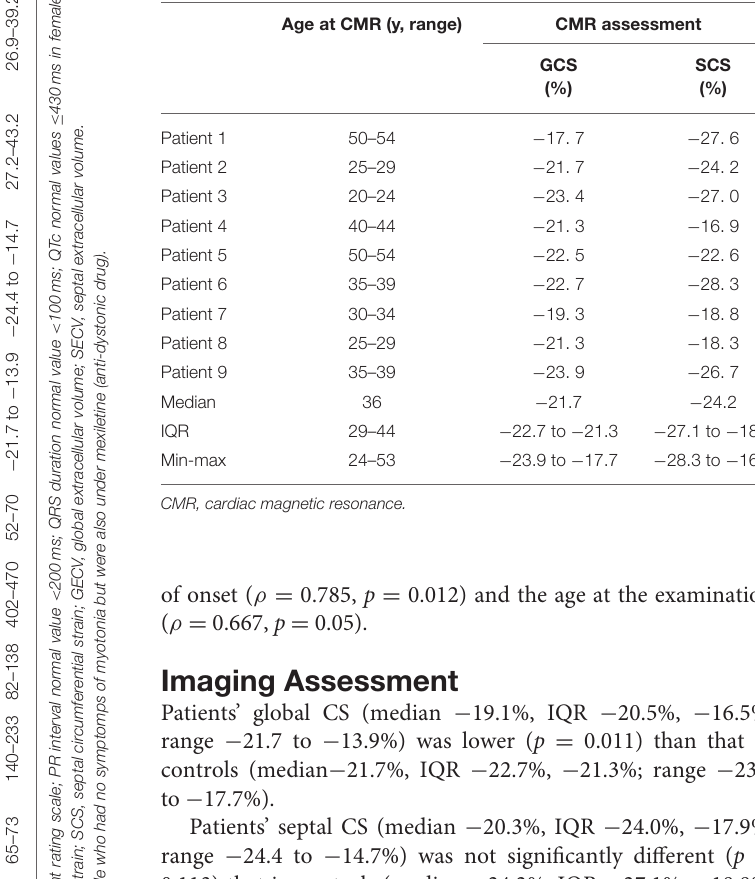
TABLE 2 | Raw imaging data of our control